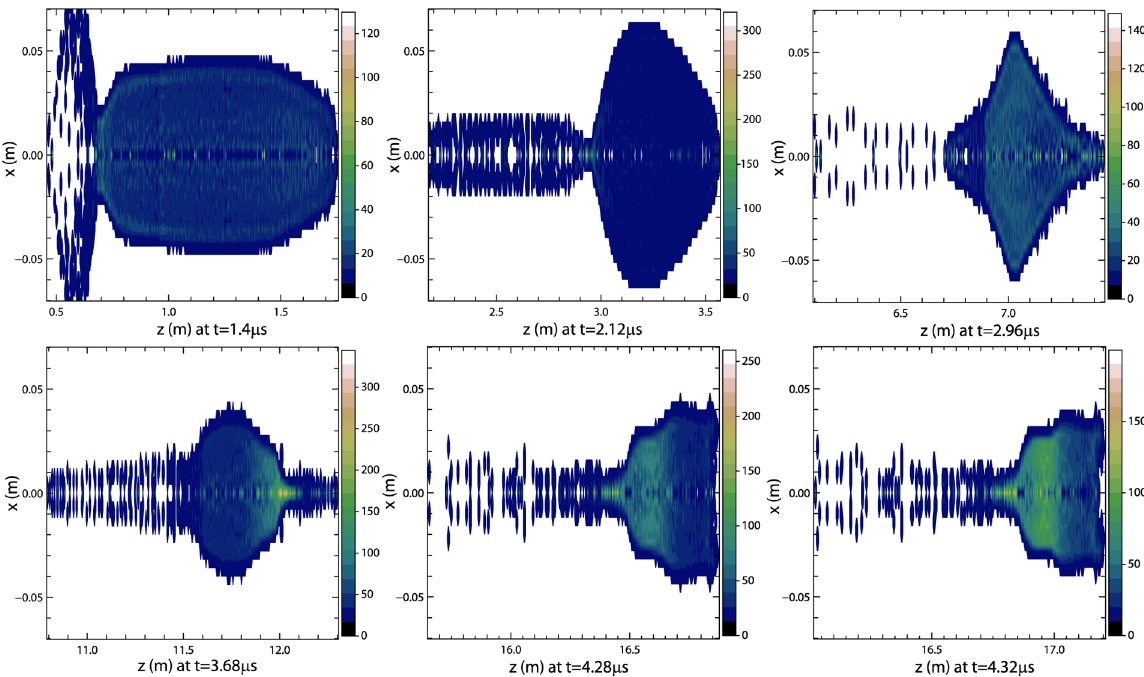
FIG. 12. (Color) Contours of charge density (in (cid:2) C = m 3 ) of the ion beam in the X - Z plane at different